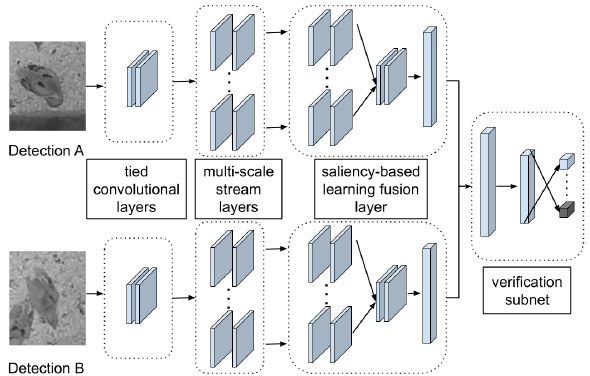
Figure 3. Overview of the MuDeep architecture.